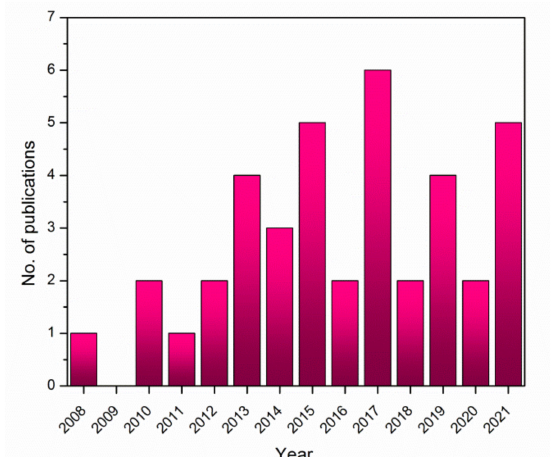
Figure 1. Number of publications per year (for years between 2008 and 2021) regarding textile dyeing using bacterial pigments, according to Scopus